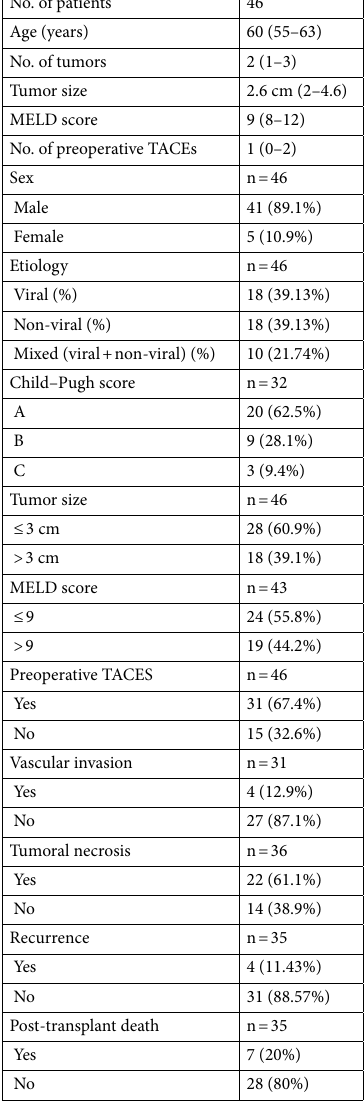
Table 1. Baseline and pathologic characteristics of 46 patients with HCC on the waiting list for LT. Variables are represented by median and interquartile range or by frequency and percentage, as appropriate. HCC hepatocellular carcinoma, MELD model for end-stage liver disease.